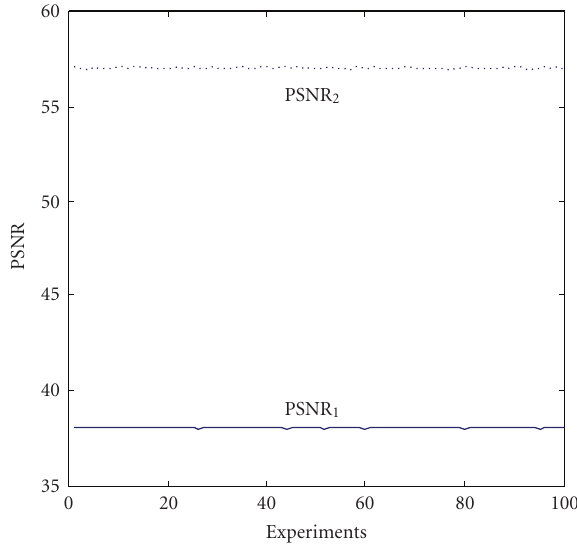
Figure 6: PSNR of Y 1 and Y 2 .